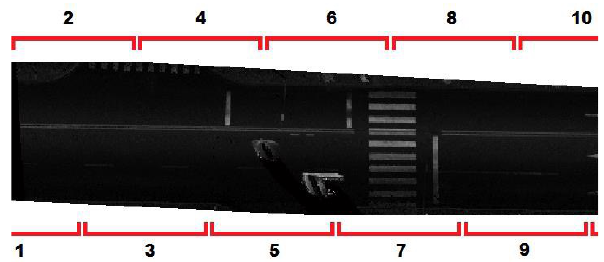
Figure 4. Example of road segmentation and strips with overlap of 50 %.